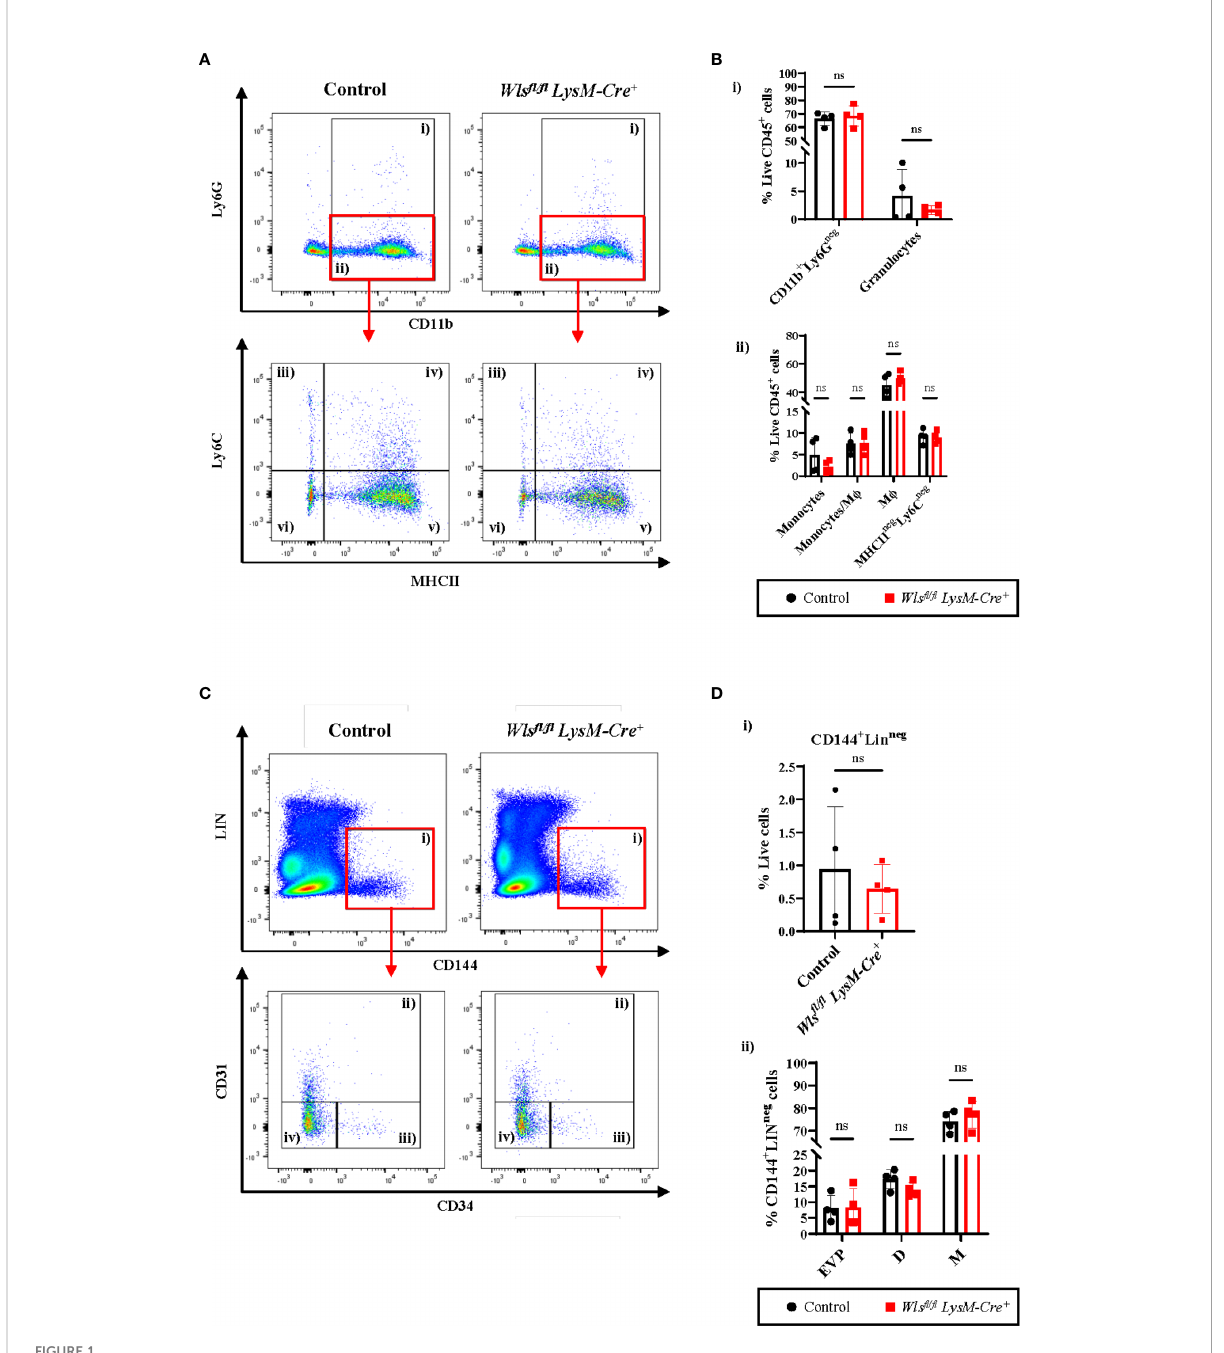
FIGURE 1 Myeloid Wntless (Wls) deletion does not have signi fi cant impact on the endothelial hierarchy and the myeloid populations during skin homeostasis. (A) Representative fl ow cytometry plots and gating strategy used to identify myeloid subpopulations in the skin of Wls fl / fl LysM- Cre + and Wls fl / fl LysM-Cre neg mice. Granulocytes were gated as CD11b + Ly6G + cells (gate i). CD11b + Ly6G neg cells (gate ii) were subsequently gated into Ly6C + MHCII neg monocytes (gate iii), Ly6C + MHCII + monocytes/M f (gate iv), Ly6C neg MHCII + M f (gate v) and Ly6C neg MHCII neg cells (gate vi). (B) Percentage of live CD45 + (i) granulocytes and CD11b + Ly6G neg myeloid cells consisting of (ii) monocytes, monocytes/M f , M f and Ly6C neg MHCII neg cells of Wls fl / fl LysM-Cre + and Wls fl / fl LysM-Cre neg (Control) mice. (C) Representative fl ow cytometry analysis of the endothelial hierarchy in the skin of Wls fl / fl LysM-Cre + and Wls fl / fl LysM-Cre neg mice during homeostasis. (C) CD144 + Lin neg cells (gate i) consists of CD31 + CD34 + D (gate ii), CD31 neg CD34 + EVP (gate iii) and CD31 neg CD34 neg M (gate iv) cells. (D) Percentage of live (i) CD144 + Lin neg cells and (ii) EVPs, D and M cells in the skin of Wls fl / fl LysM-Cre + and the Wls fl / fl LysM-Cre neg control littermates. No difference was observed in the total percentage of CD144 + LIN neg endothelial cells, as well as the EVP, D and M between the two groups. Data are represented as mean ± SD. Statistical analysis was performed using unpaired Student t-tests. ns= not signi fi cant. Data are representative of 4 individual animal